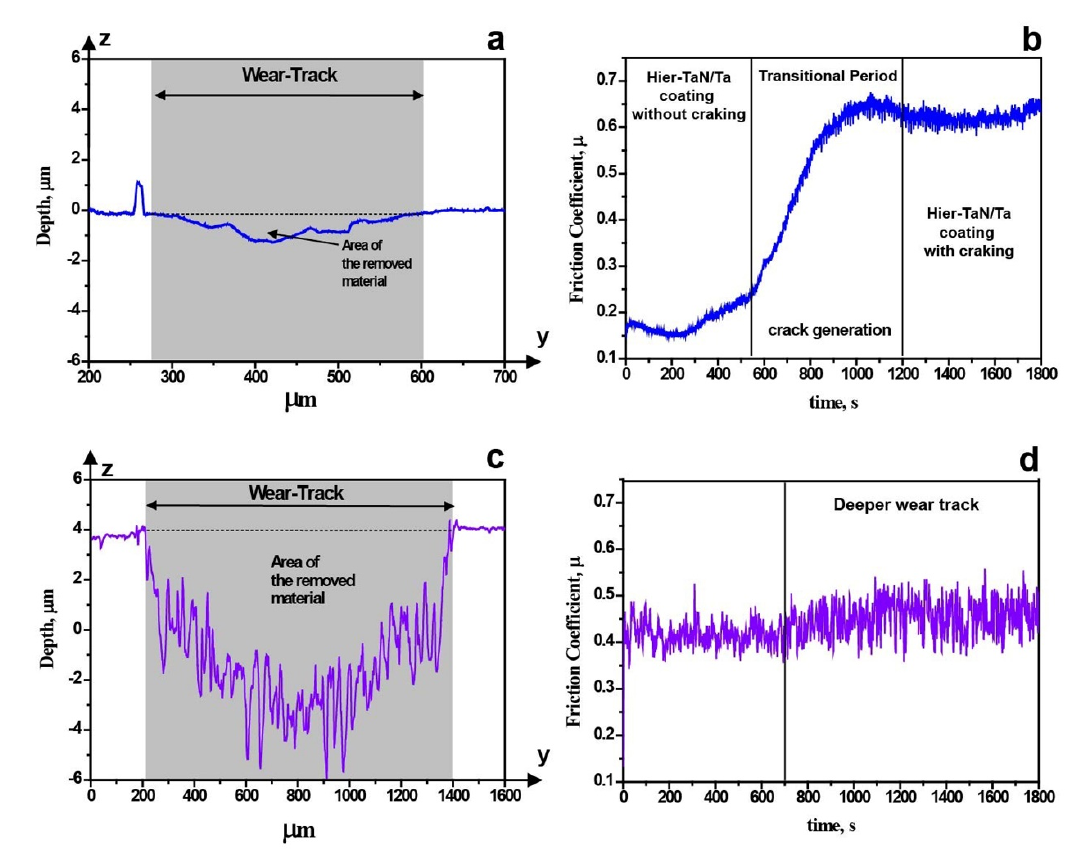
Figure 8. Typical wear track profile obtained by the macro-tribology tests for ( a ) Hier-TaN / Ta coating and ( c ) Ti6Al4V substrate. Friction coe ffi cient obtained during the macro-tribology test; ( b ) Hier-TaN / Ta coating and ( d ) Ti6Al4V substrate.